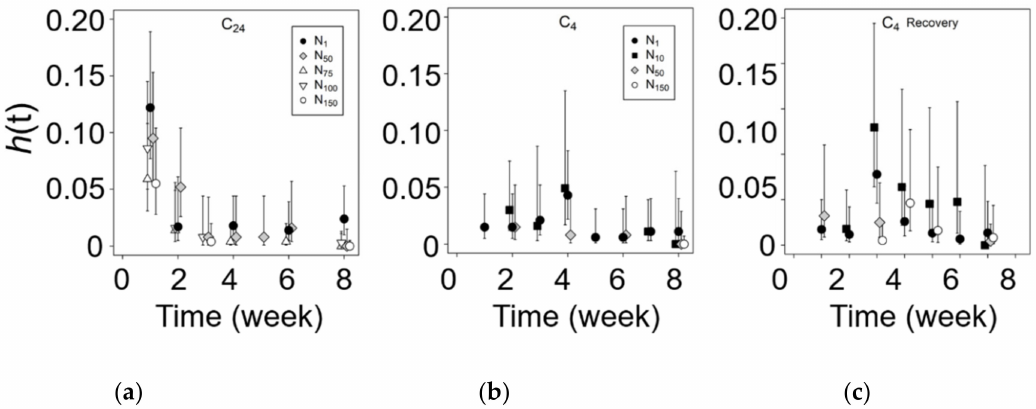
Figure 4. Hazard function, h ( t ), under di ff erent salinity during germination ( a , b ) and recovery ( c ). Mean ± 95% CI bars. Same symbols in all graphs. See Figure 2 for further methodological